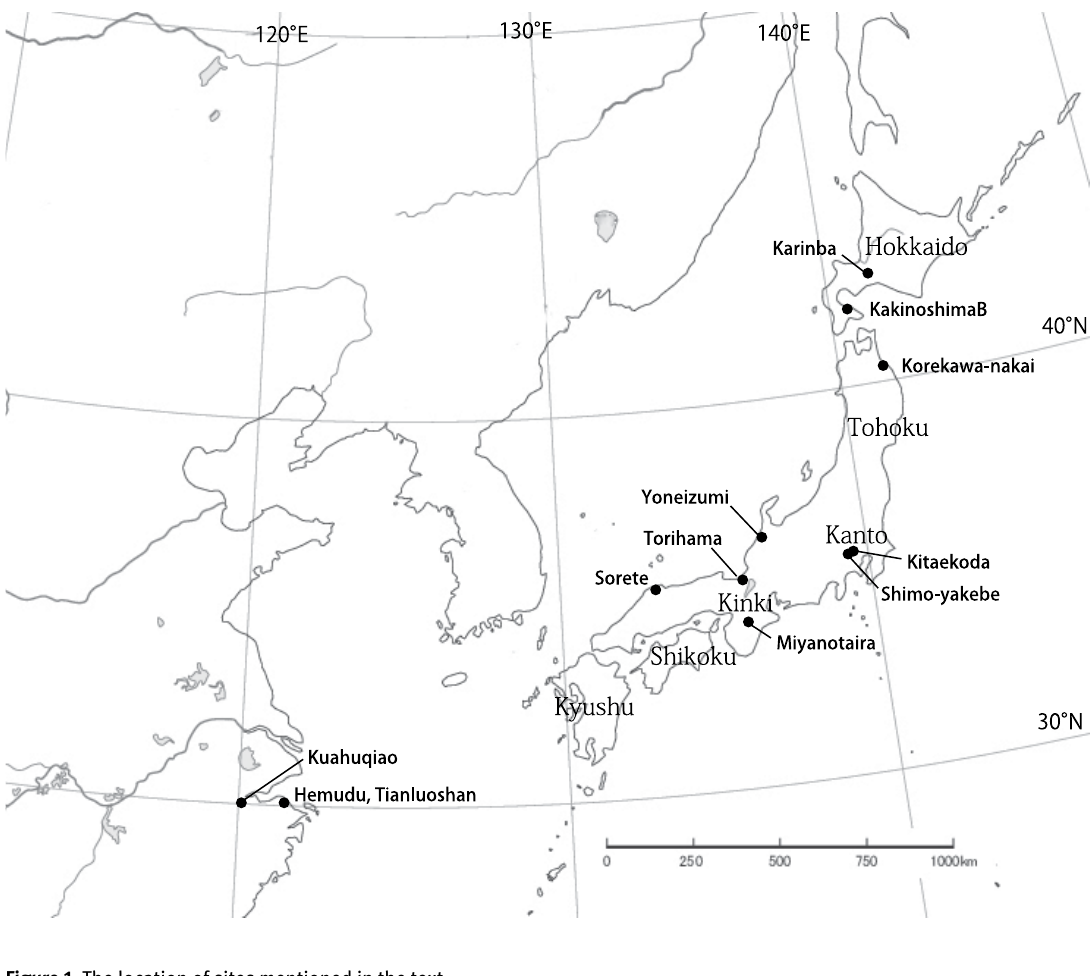
Figure 1. The location of sites mentioned in the text. Table 1. Approximate dates (calibrated BP) for the six